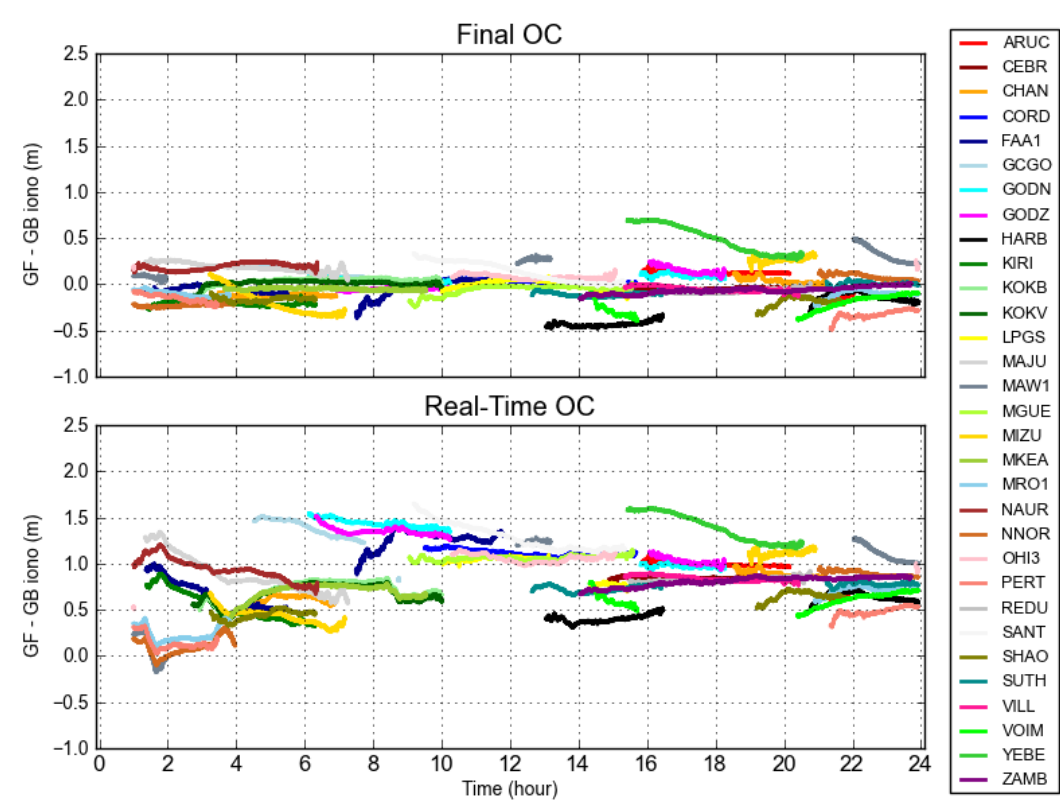
Figure 12. GF–GB ionospheric delays for PRN 09 for all sites, GB ionospheric delays derived from the final OC (top) and real-time OC (bottom).